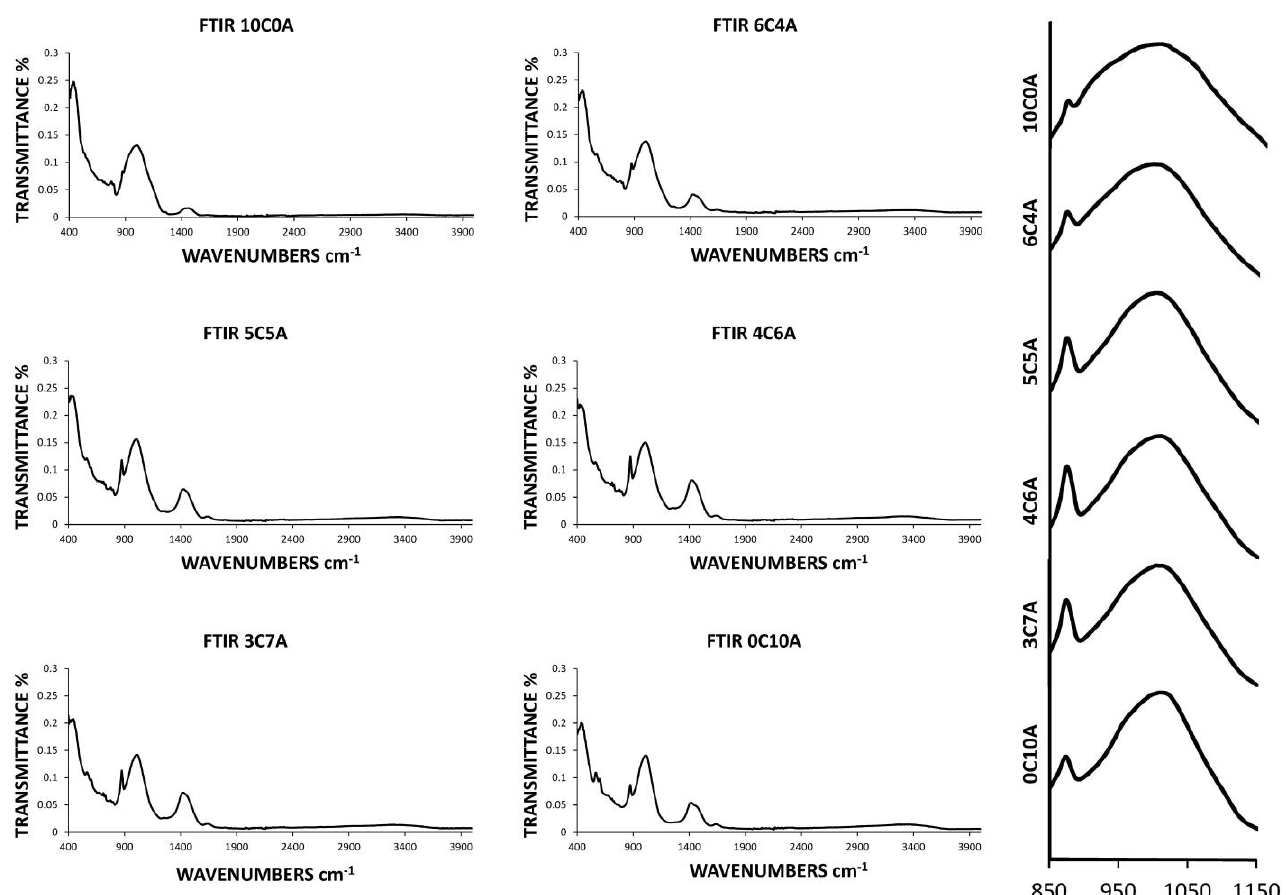
Figure 7. Fourier transform infrared (FTIR) analysis of the families with acceptable results (6C4A, 5C5A, 4C6A and 3C7A), as well as of the family with 100% chamotte (10C0A) and the family with 100% BBA (0C10A). On the right, a comparison of the intensity of the spectra for the families detailed in the region 850 – 1150 cm −1 is shown.